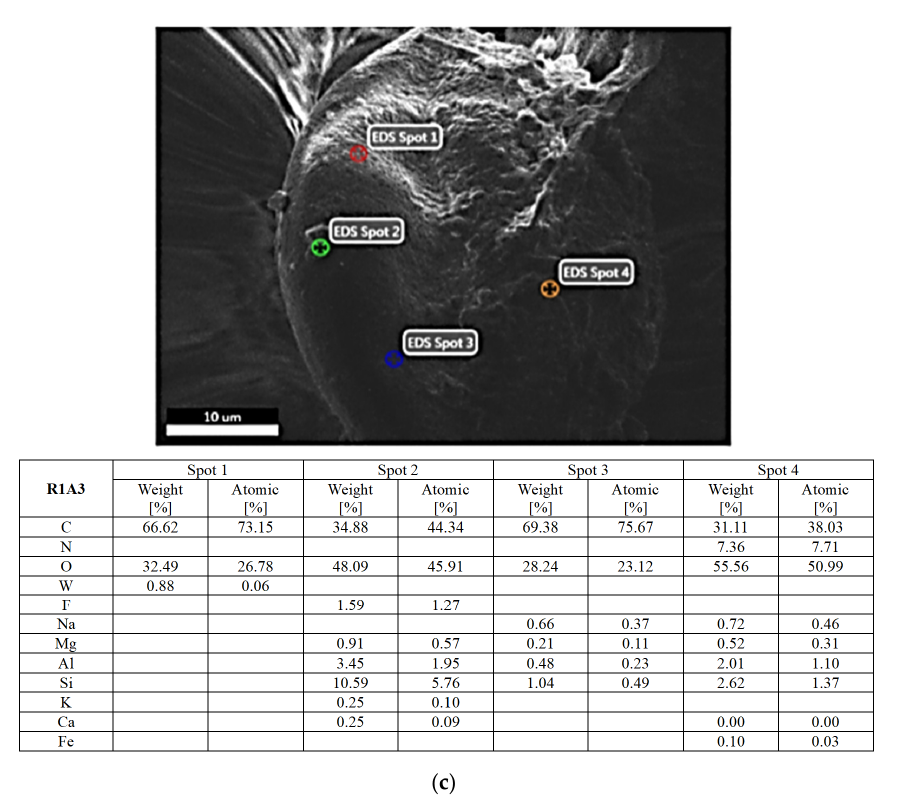
Figure 7. Report 1 of SEM-EDS results of analyzed areas of dry material decanted from rainwater: